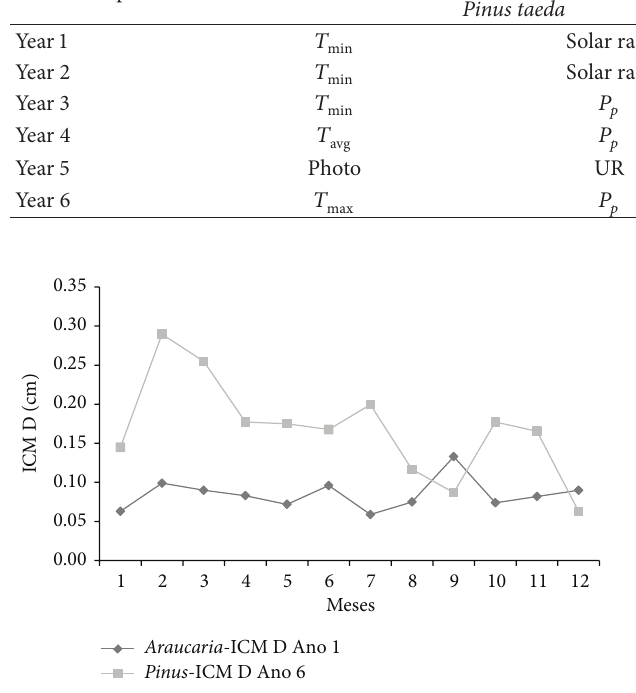
Figure 2: Current monthly increment in diameter in the first year of measurement for Araucaria angustifolia and in the sixth year of measurement for Pinus taeda